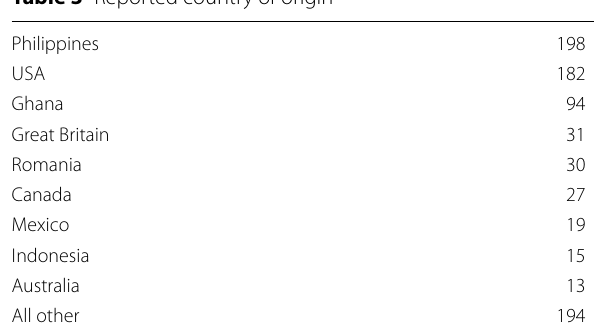
Table 3 Reported country of origin